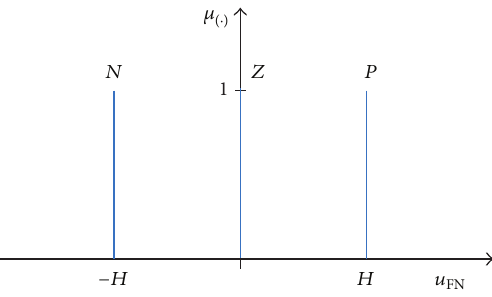
Figure 3: The output membership